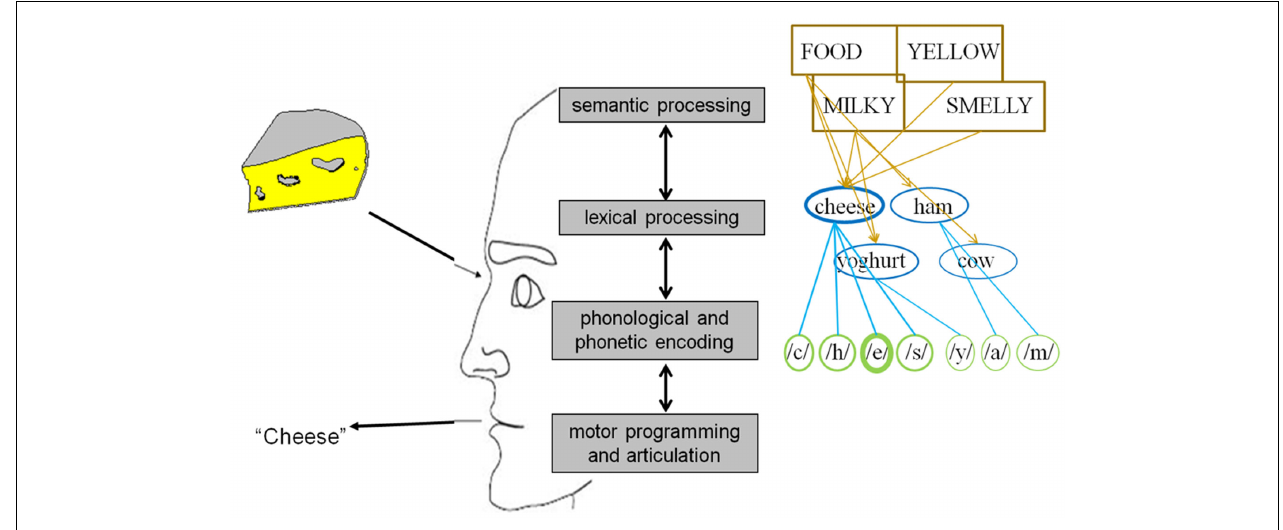
FIGURE 1 | Simple and schematic model of object